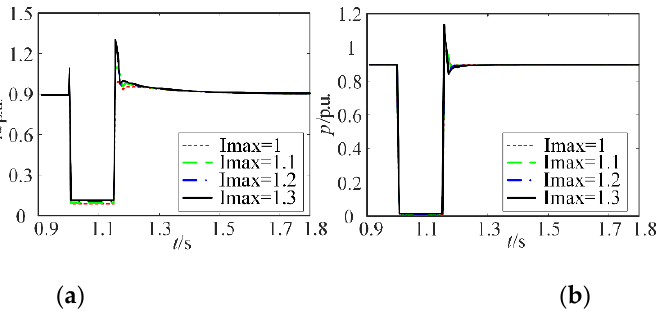
Figure 13. Simulation results in cases (5)–(8) of the fault of Bus7: ( a ) active current; ( b ) active out- put.